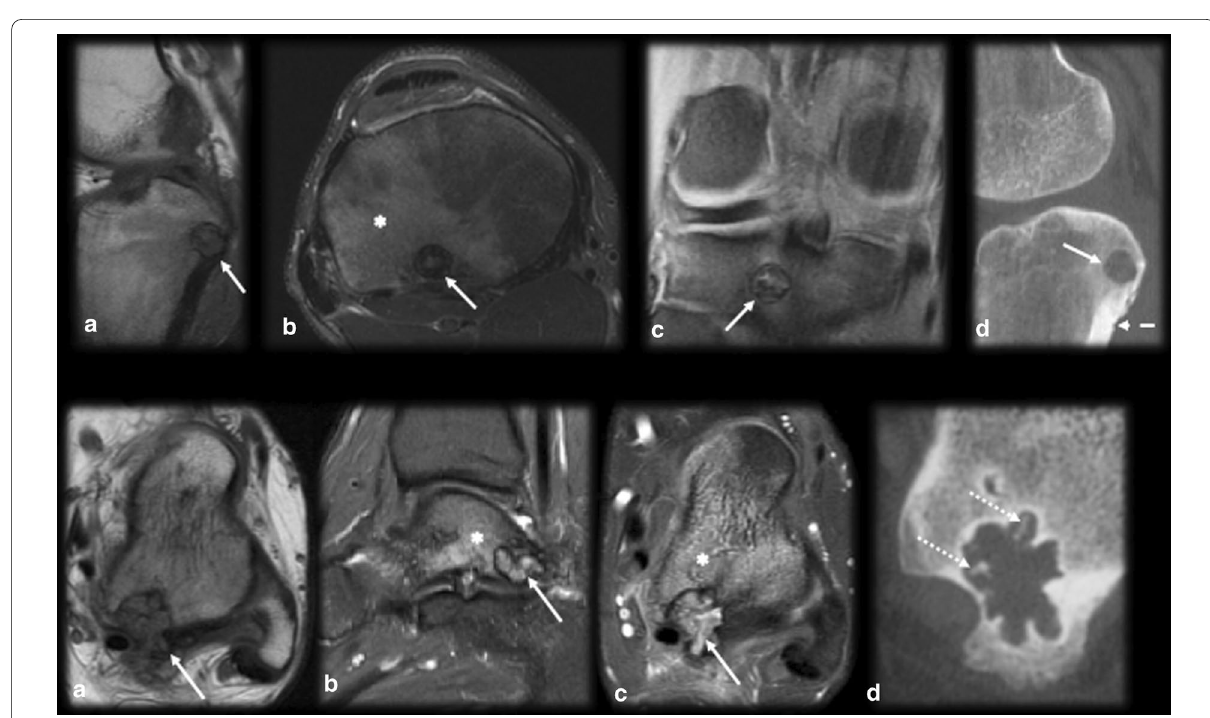
Fig. 15 Osteoid osteoma versus chondroblastoma. ( a – d ) Male, 29 years old, presenting with knee pain for 3 months. MRI sagittal T1 ( a ), axial and coronal T2 FS ( b , c ) and CT ( d ) showed a round and central mineralized nidus (arrows) with reactional bone marrow edema (asterisk) and cortical thickening (dashed arrow in d). ( e – h ) Male, 24 years old, presenting with ankle pain for 9 months. MRI axial T1 ( e ), sagittal T2 ( f ), axial T1 FS GD ( g ) and CT ( h ) showed a large and lobulated bone lesion (arrows) with peripheral arciform calcifications (dotted arrows), internal enhancement ( c ) and reactional bone marrow edema